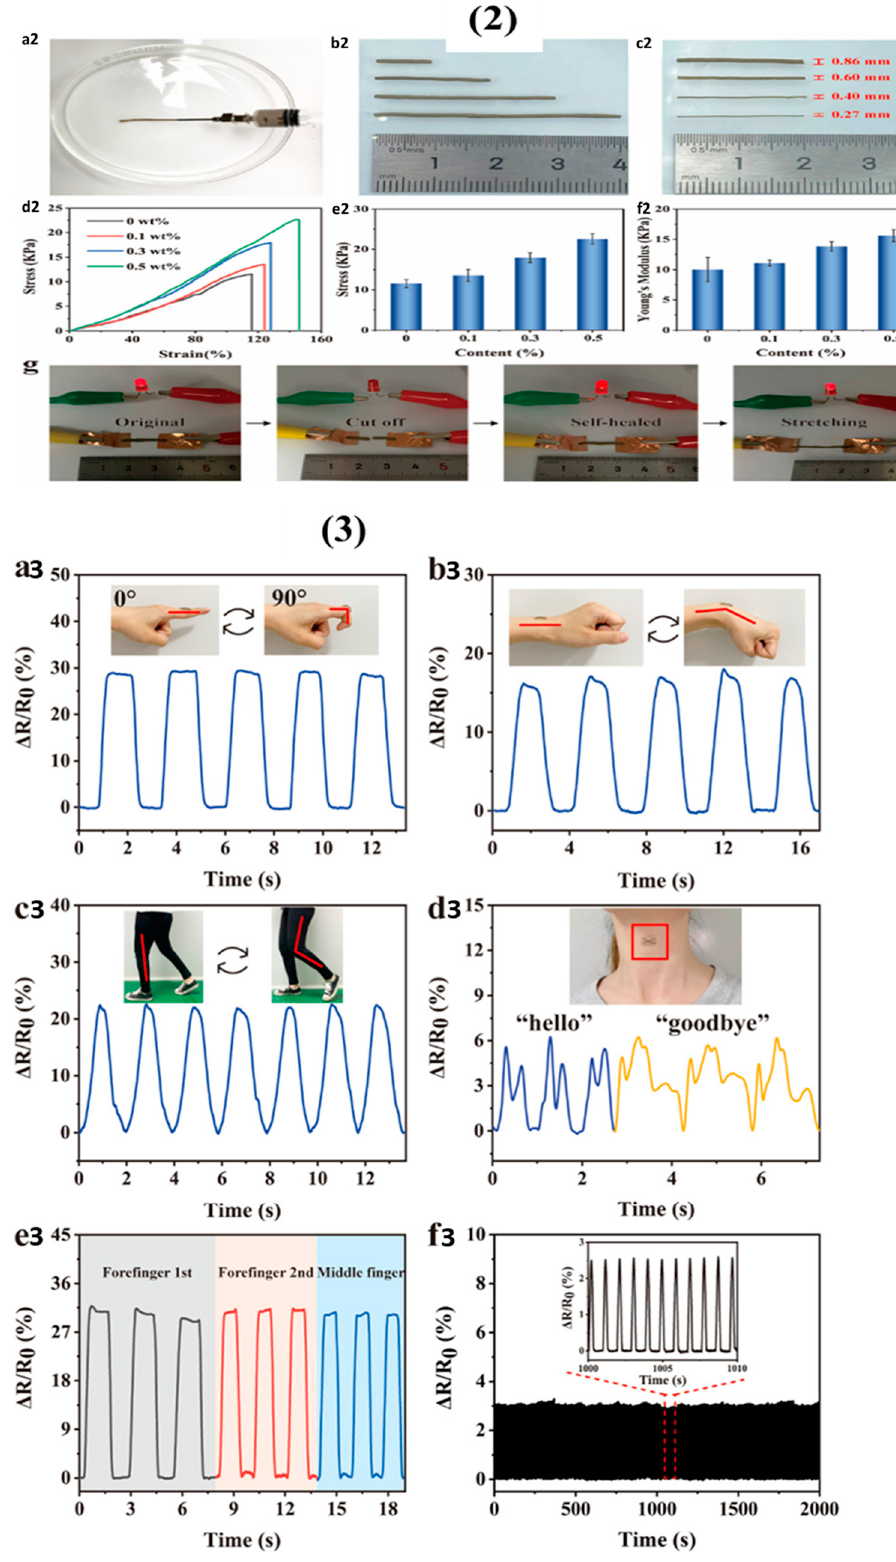
Figure 22. Fabrication procedures and schematic structures of PHSSs ( 1 ); mechanical and conductive properties of injected Ag NWs/AA hydrogel wires ( 2 ); application of the PHSS as strain and motion sensors ( 3 ) (adapted with permission from Zhao et al., 2022).